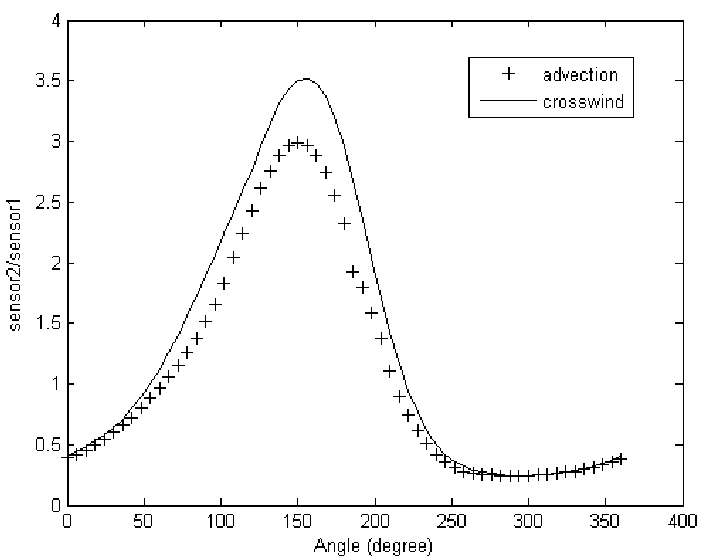
Figure 5. Calculat ion scheme of peak point